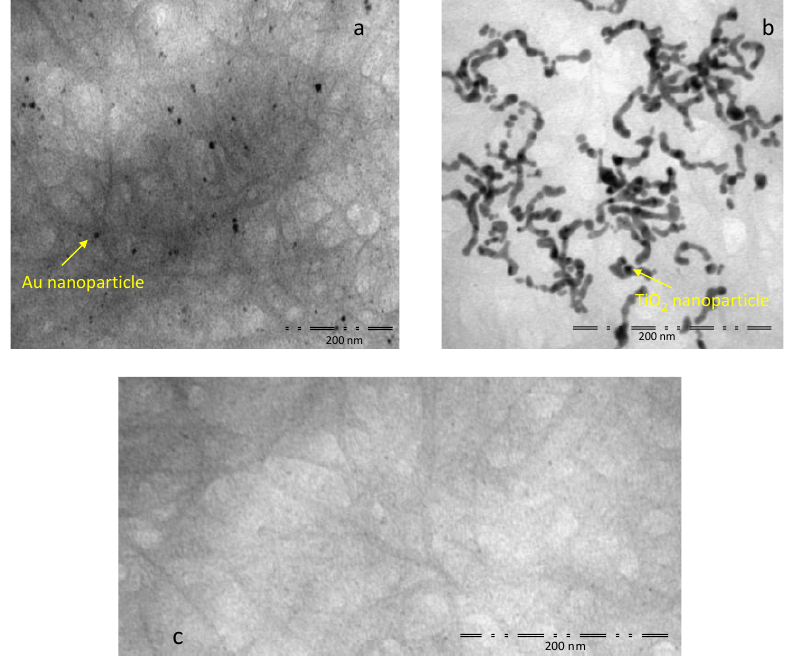
Figure 4. High-resolution Transmission Electron Microscopy (TEM) images of the decorated samples: ( a ) SWCNT-Au nanoparticles, Scale bar = 200 nm; ( b ) SWCNT-TiO 2 nanoparticles, Scale bar = 200 nm; ( c ) SWCNT, Scale bar = 200 nm; the investigation was performed using a Tecnai G2 Spirit (FEI) operated at 120 kV.